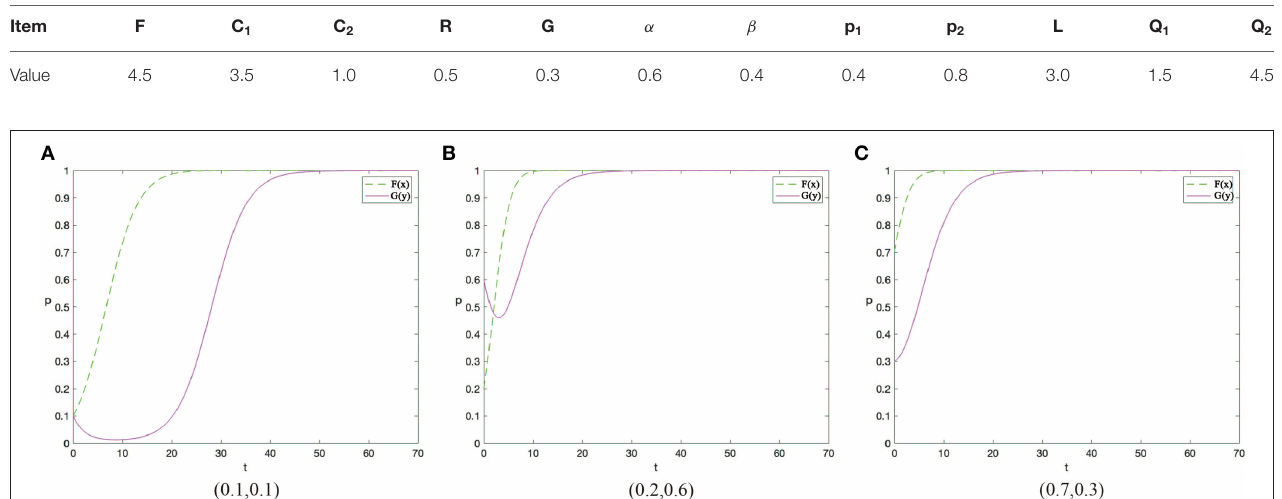
TABLE 5 | The parameter settings of scenario 2. Item